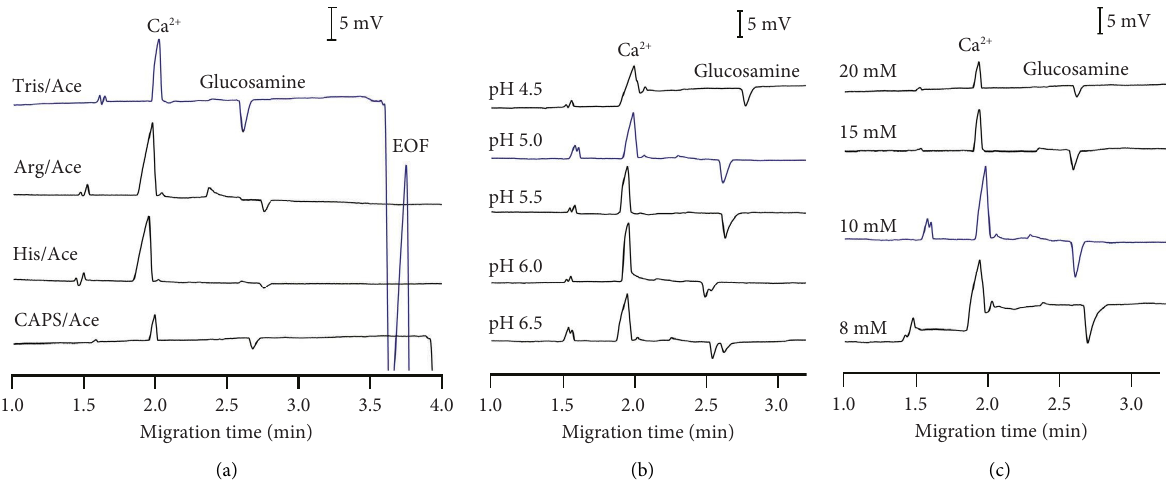
Figure 1: Optimization the BGE conditions for simultaneous determination of glucosamine and calcium. (a) Te efect of BGE com- positions. (b) Te efect of pH. (c) Te efect of Tris concentration. CE conditions: fused silica capillary (total length 40cm, efective length 30cm, ID 50 μ m); separation voltage +20kV; hydrodynamic injection (siphoning at 25 cm in 30 s). Te selected conditions were highlighted in